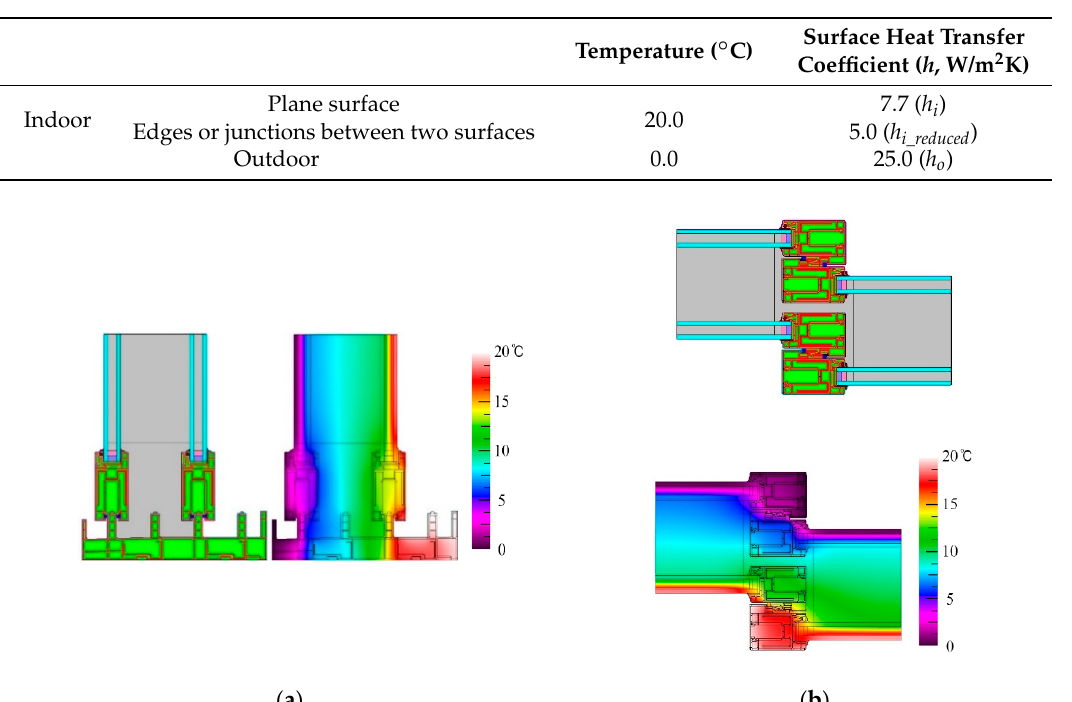
Table 7. Boundary conditions for U-factor simulations.